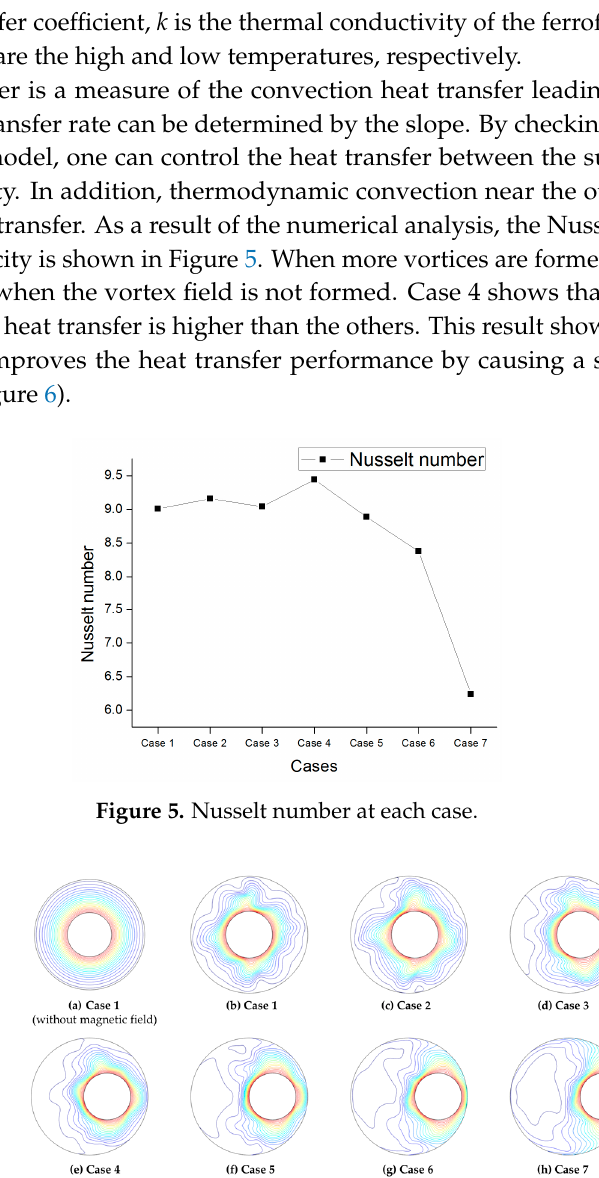
Figure 6. Isotherms at each case.